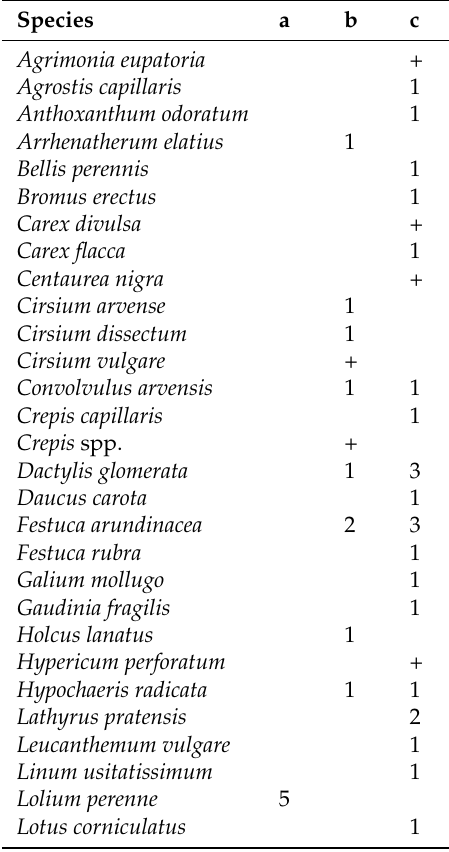
Table A1. Braun-Blanquet abundance-dominance coefficients associated with each plant species recorded in three grasslands a, b and c having a Shannon index of 0.10, 1.57 and 2.89, respectively. “spp.” means that the species from the given genus was not